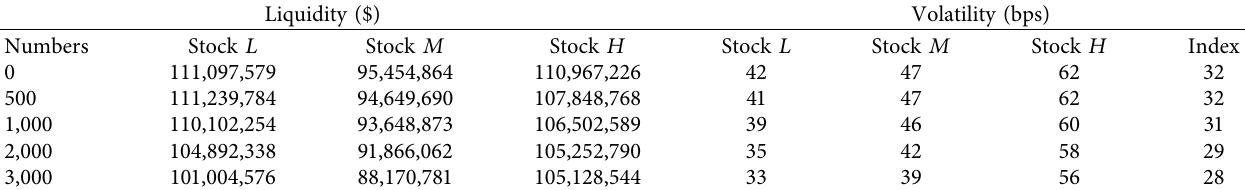
Table 12: Impact of futures and cash arbitrageurs on spot market liquidity and